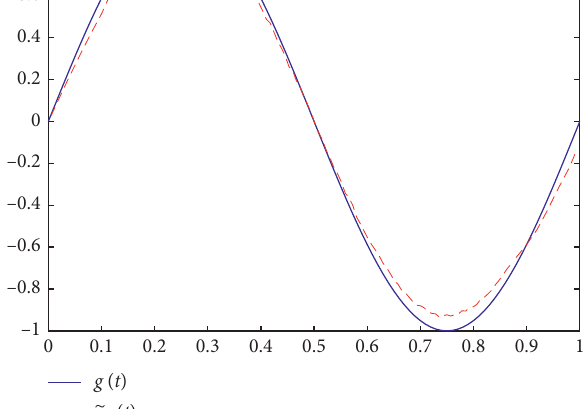
Figure 2: Curves of g ( t ) � sin ( 2 π t ) and 􏽥 g n �